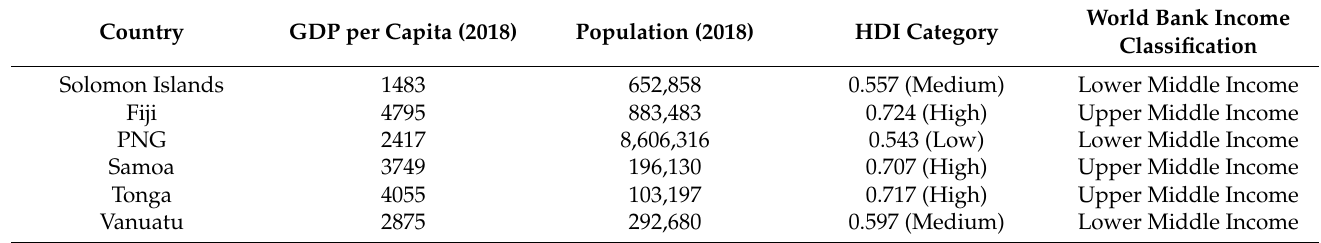
Table 1. Economic development